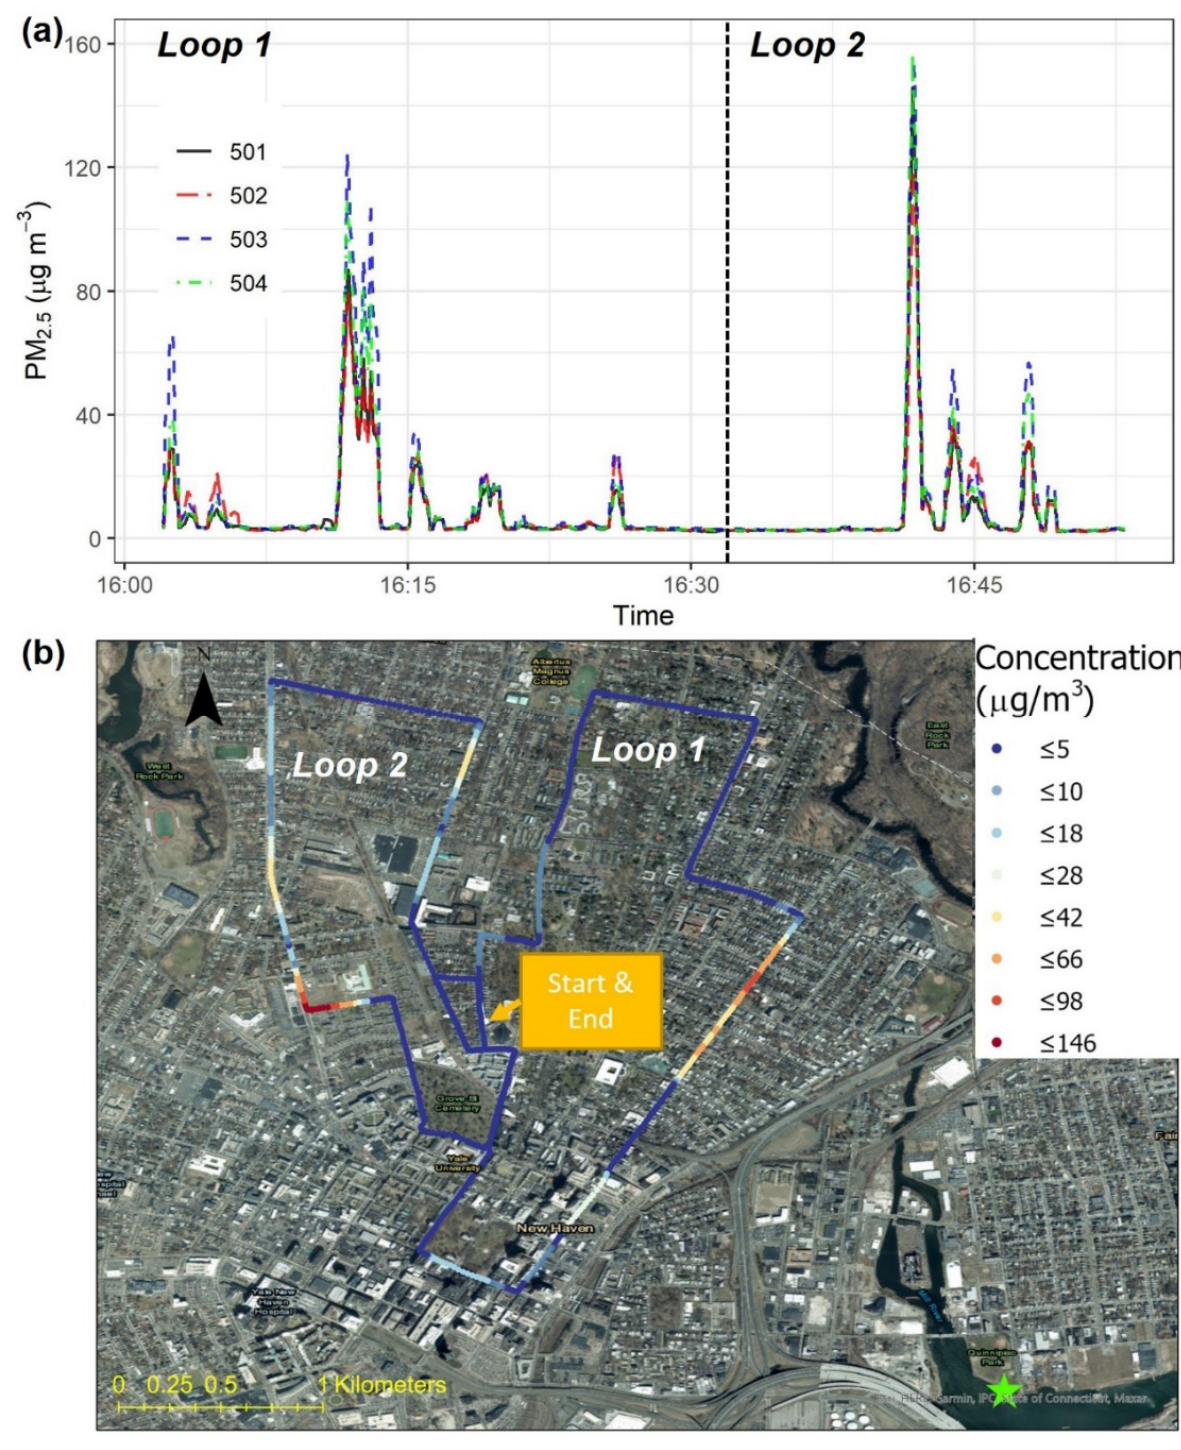
Figure 7. Car-based test in New Haven, Connecticut, U.S.: ( a ) time series of PM 2.5 concentrations measured by four Smart-P monitors (IDs: 501, 502, 503, and 504) and ( b ) map visualization of PM 2.5 concentrations measured by one Smart-P monitor (IDs: 501). The driving direction in both loops was clockwise. At the time of this test, the hourly average PM 2.5 concentration from the nearest regulatory monitor (green star) was 7.5 µg m − 3 .